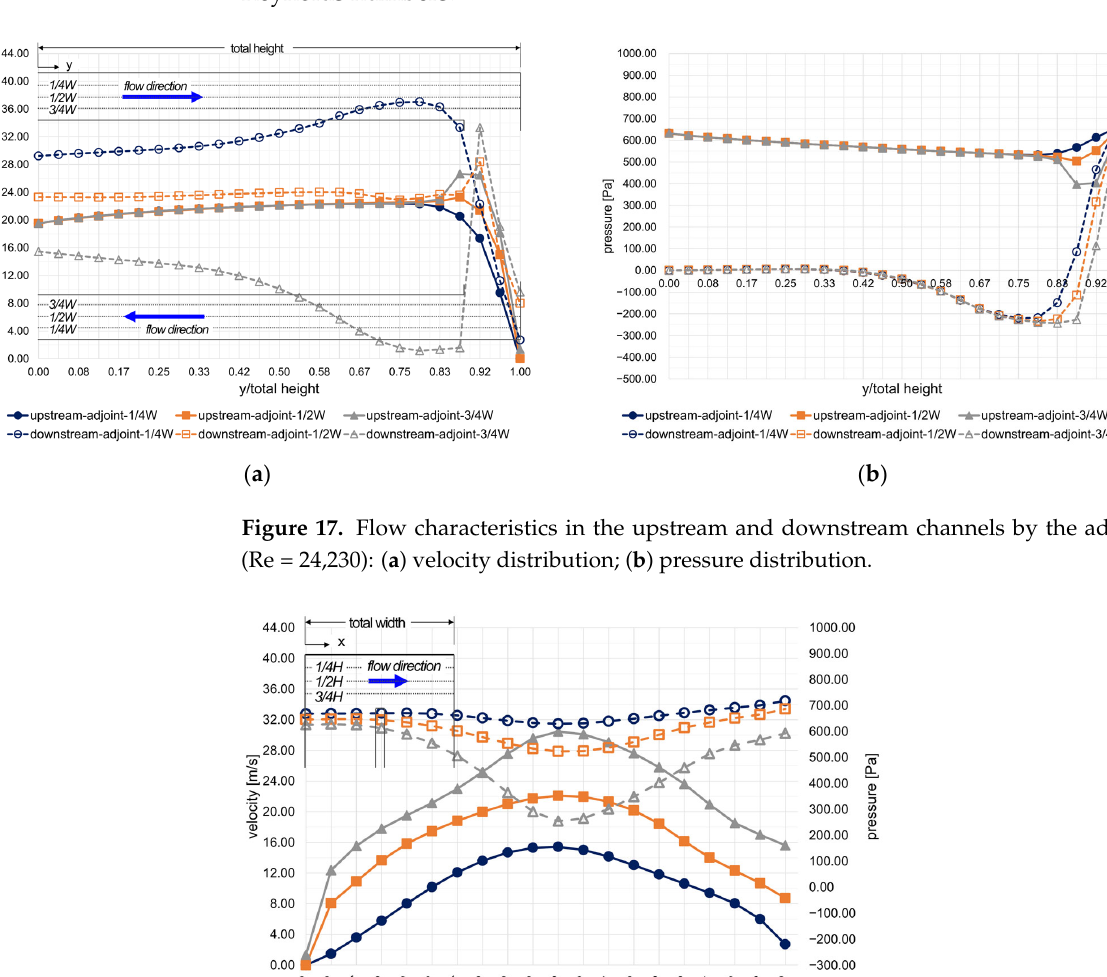
Figure 18. Flow characteristics in the turning region by the adjoint solver (Re = 24,230).